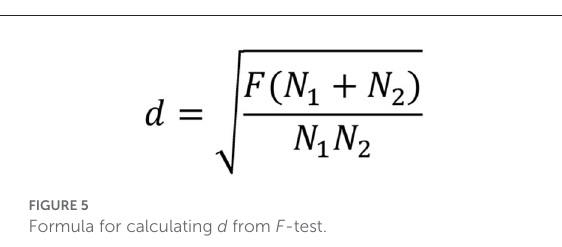
FIGURE4 Formula for converting Cohen’s d into Hedge’s g .